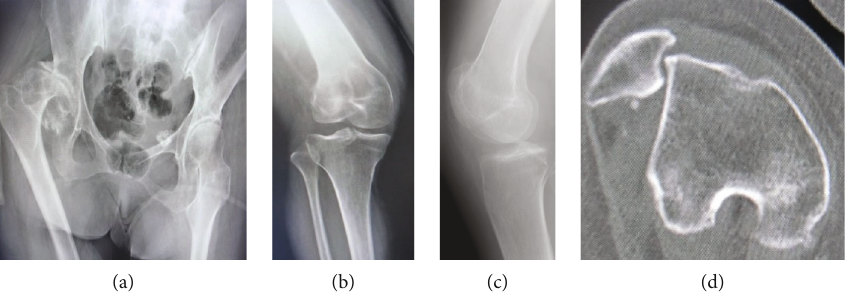
Figure 1: (a) Preoperative X-ray examination of the hip. (b) Preoperative X-ray examination of the right knee; anteroposterior view. (c) Preoperative X-ray examination of the right knee; lateral view. (d) Preoperative computed tomography of the right knee.